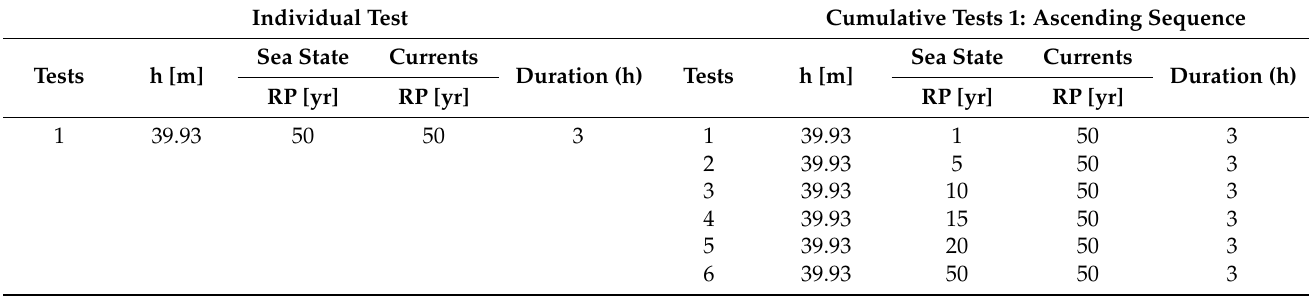
Figure 7. General view of the test setup. Table 1. (Left) Individual test. (Right) Cumulative tests 1: ascending